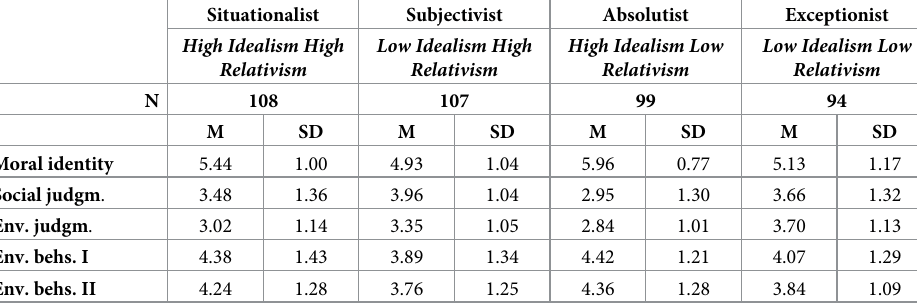
Table 10. Mean scores by ethical ideologies.